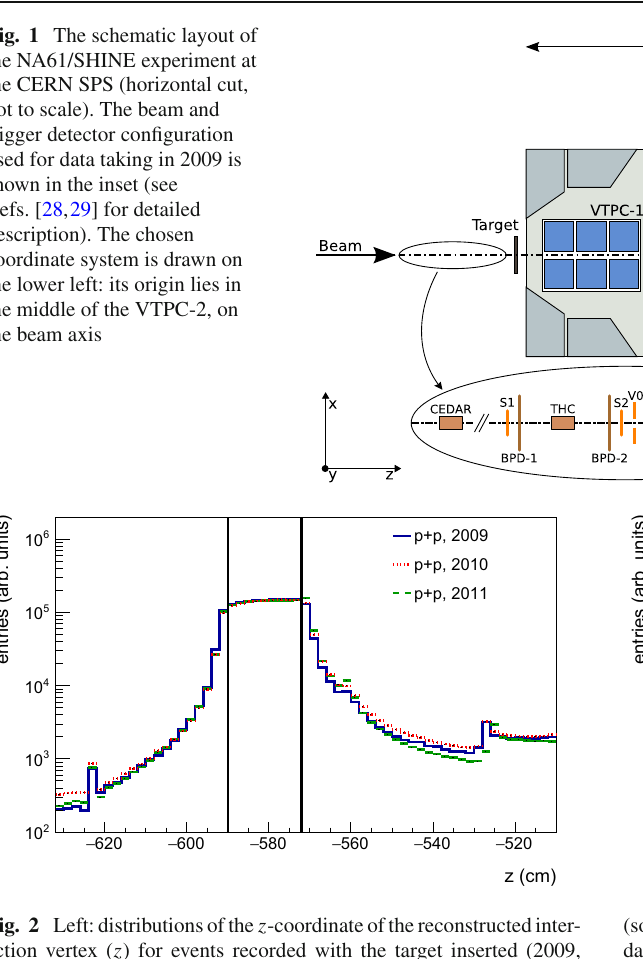
(solid histogram) and target-removed (dash-dotted histogram) 2009 data. Histograms are normalized to the same integral in the range − 450 < z < − 300 cm. All event cuts were applied (see Sect. 3.3) with exception of cut (ii) and (v). Black vertical lines indicate the cuts used for the analysis (see Sect.